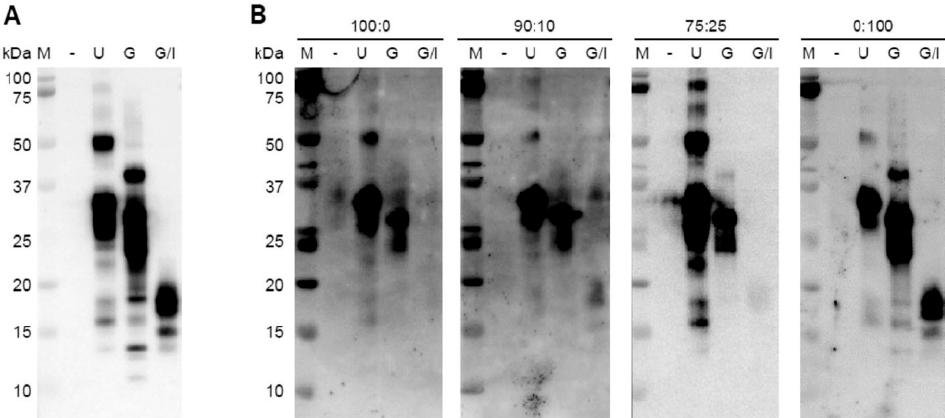
Figure 5. Epithelial transport of osteopontin (OPN) across Caco-2/HT29-MTX monolayers after sim- ulated gastrointestinal digestion. Cells were seeded at di ff erent Caco-2:HT29-MTX proportions on transwell membranes. Undigested OPN (U) and OPN after simulated gastric digestion (with pepsin (G)) or gastrointestinal digestion (with pepsin and subsequently trypsin, chymotrypsin, and elastase (G/I)) was added to the apical compartment of the monolayers. Cells only added serum-free me- dium (-) were used as control. After 2 h, apical and basolateral medium was analysed by Western blo tt ing using polyclonal anti-OPN IgG. ( A ) Apical samples are representative for all Caco-2:HT29- MTX proportions. ( B ) Basolateral samples from the di ff erent cell cultures. The Caco-2:HT29-MTX seeding proportions are given above the gels. The blots are representative of two individual exper- iments.